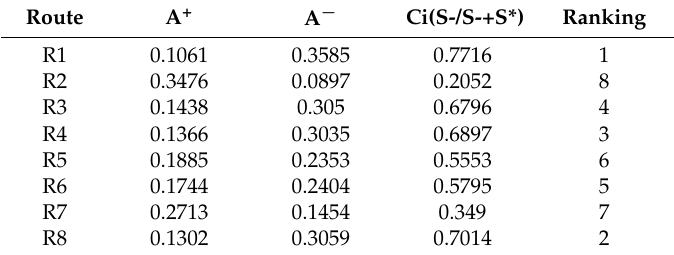
Table 9. Final ranking in two-phase ANP-TOPSIS approaches.